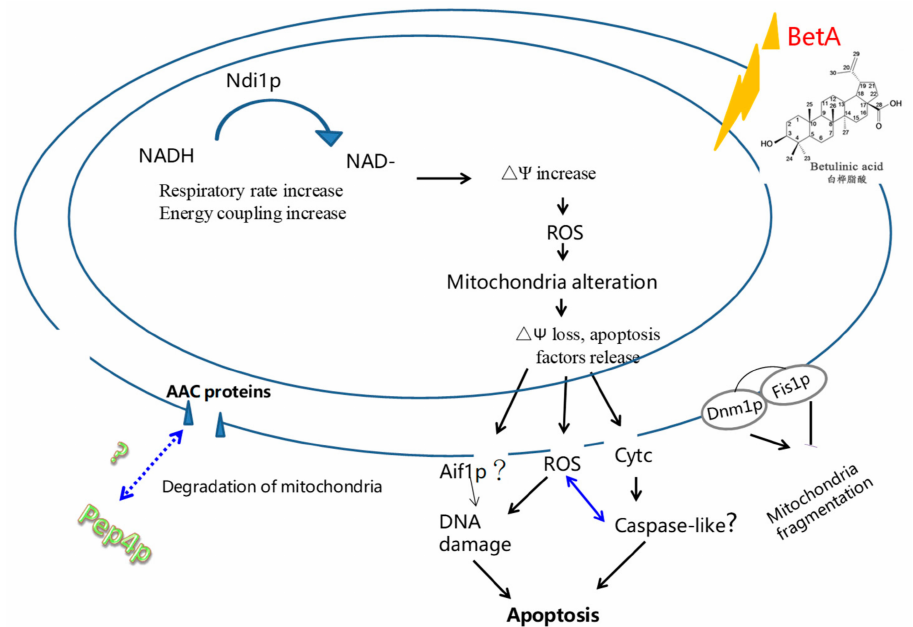
Figure 9. The postulated reaction pathway by BetA-induced PCD in yeast cells through a mitochondria mediated pathway. What is more, the Pep4p provide yeast cells a protection for its cleaning function. represent a defined interaction, represent a progressive flow relation, represents the interaction to be